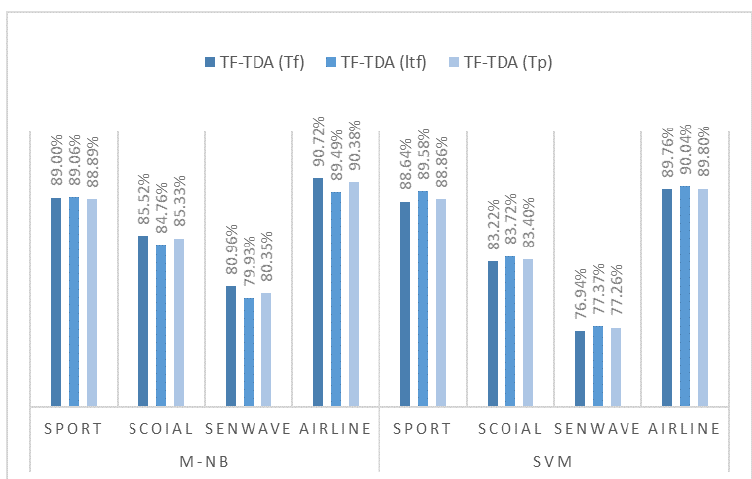
Figure 6. TF-TDA using different local